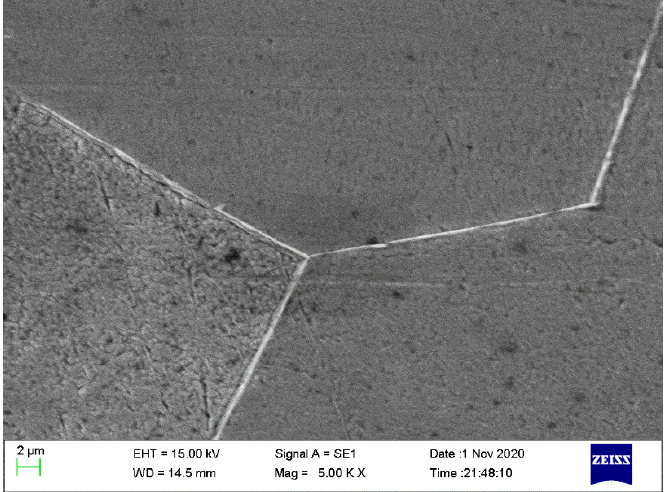
Figure 3. Scanning electron microscopy of grain boundaries of a silicon steel plate.